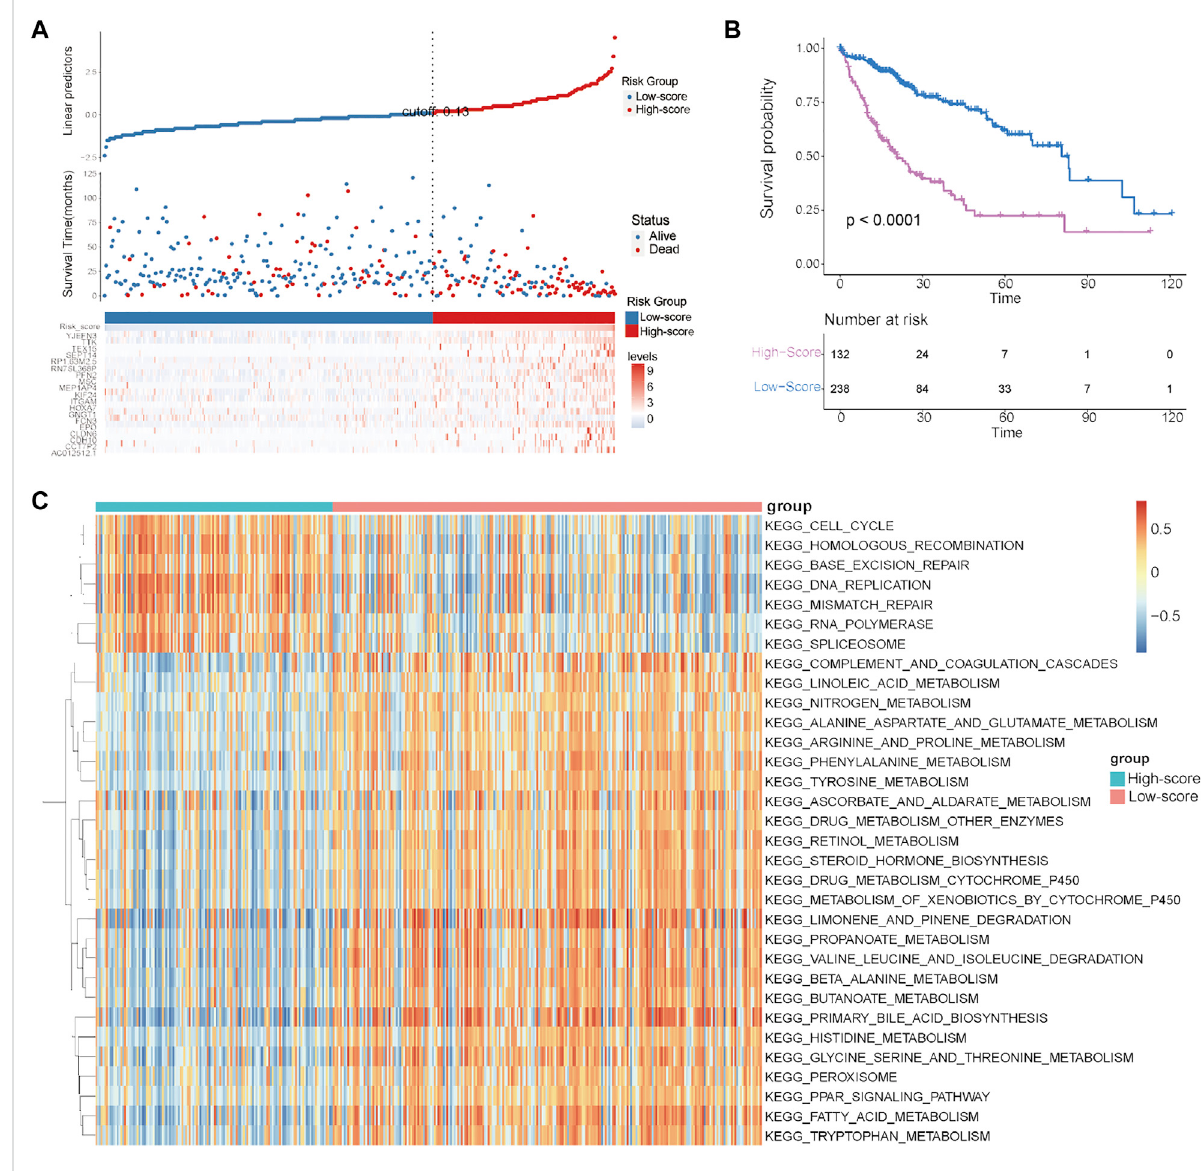
FIGURE 5 Establishmentandevaluationofthecuproptosis-relatedriskscoreintheTCGA – HCCcohort. (A) SurvivalstatusofHCCpatientsandexpression of the 19 signi fi cant prognostic DEGs in the high- and low-score groups. (B) Kaplan – Meier curve for the two risk groups. (C) GSVA results showing the functional characteristics in the two risk